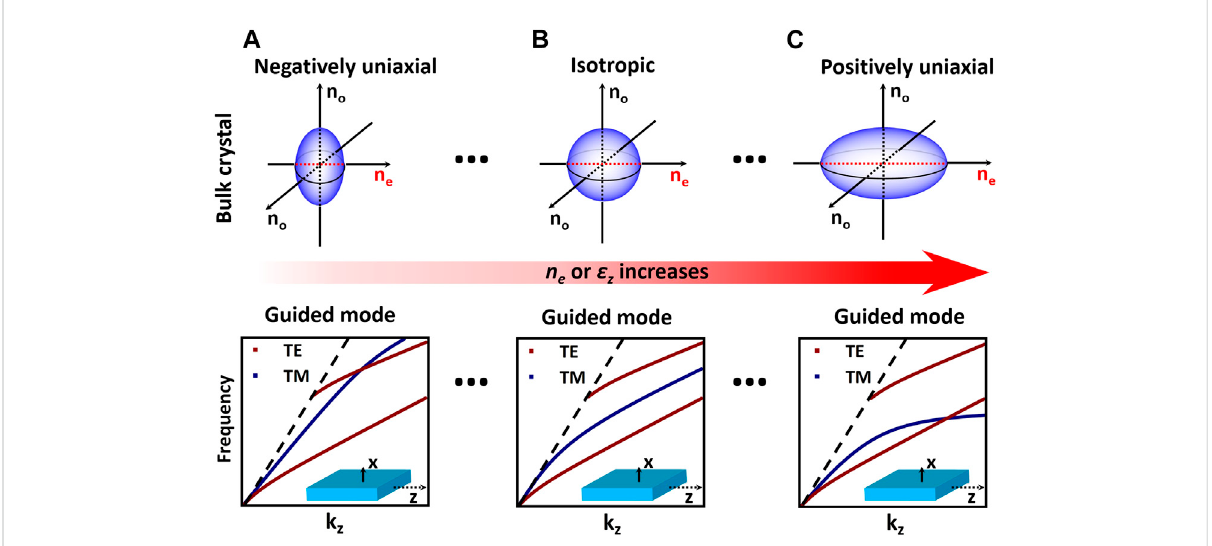
FIGURE 1 Schematicsfortheindexellipsoids(upperrow)inauniaxialbulkcrystalwheretheopticalaxis n e isalongthehorizontaldirection,andtheguided modes (lower row)intheuniaxial crystal slabwiththe fi nitethickness alongthe x -direction asillustratedbytheinsets.The propagation oftheguided modes is assumed along the optical axis, i.e., horizontal direction, labeled as z -axis in the insets. The dark red lines denote TE modes, the dark blue lines denote TM modes, and the dash lines denote the light line. n e or ε z increases from left to right, as indicated by the arrow, and shows (A) negatively uniaxial, (B) isotropic, and (C) positively uniaxial